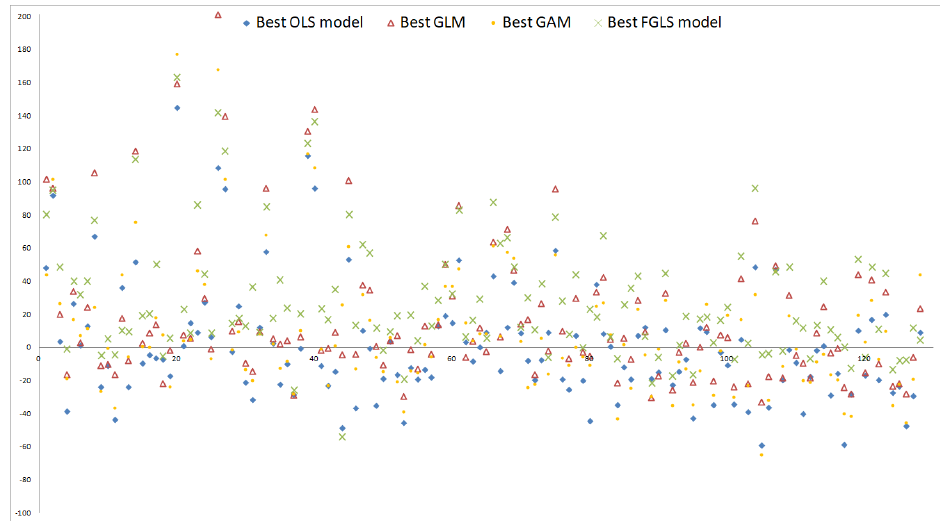
Figure 10. Residual plots on capital region set